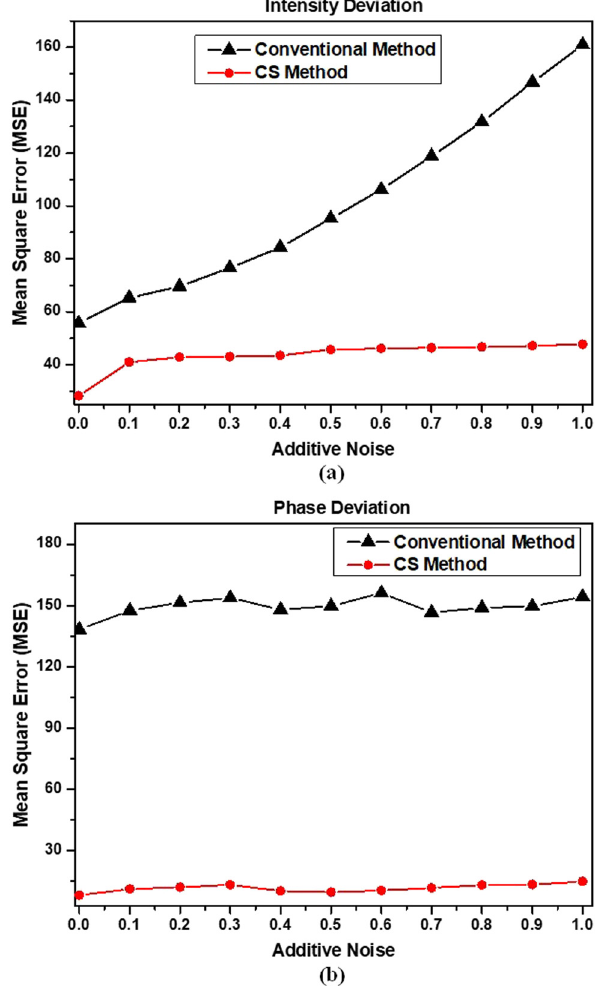
Figure 6: MSE between original and reconstructed USAF resolution chart versus the standard deviation of the additive noise ( a ) intensity deviation and ( b ) phase